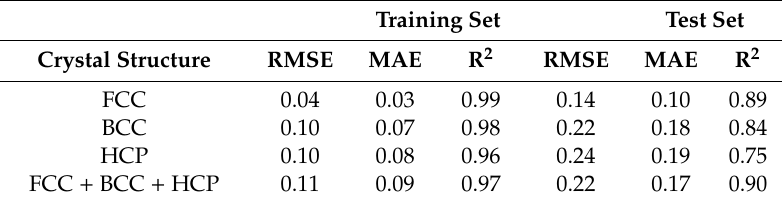
Figure 3. GBR model predictions for FCC(111) surfaces using ( A ) 11 features and ( B ) 5 features. SSE = surface segregation energy. Table 3. RMSE, MAE and R 2 values for training and test sets obtained from the GBR model using 11 features.